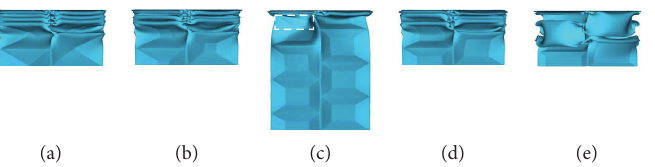
Figure 9: Deformation modes of four representative square prefolded tubes with different values of R : (a) S5-R0-72; (b) S5-R25-72; (c) S5- R50-72; (d)